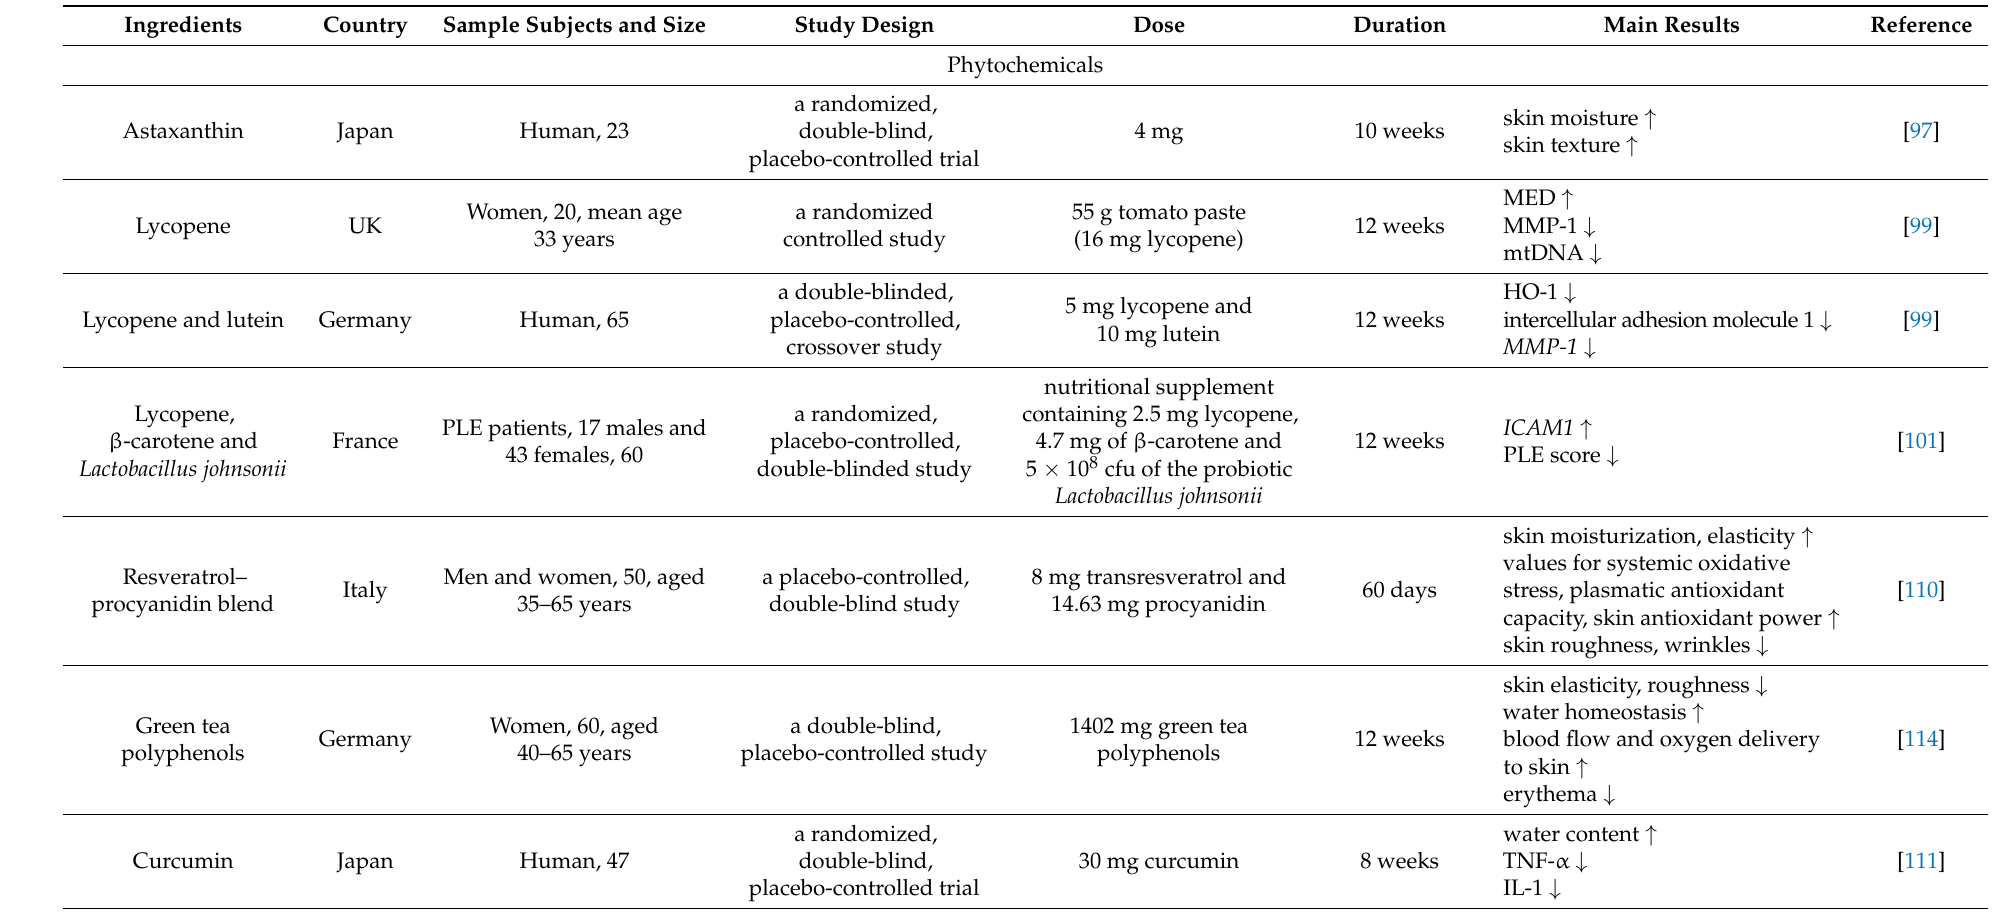
Table 2. Summary of dietary components to boost photoaged skin health in clinical